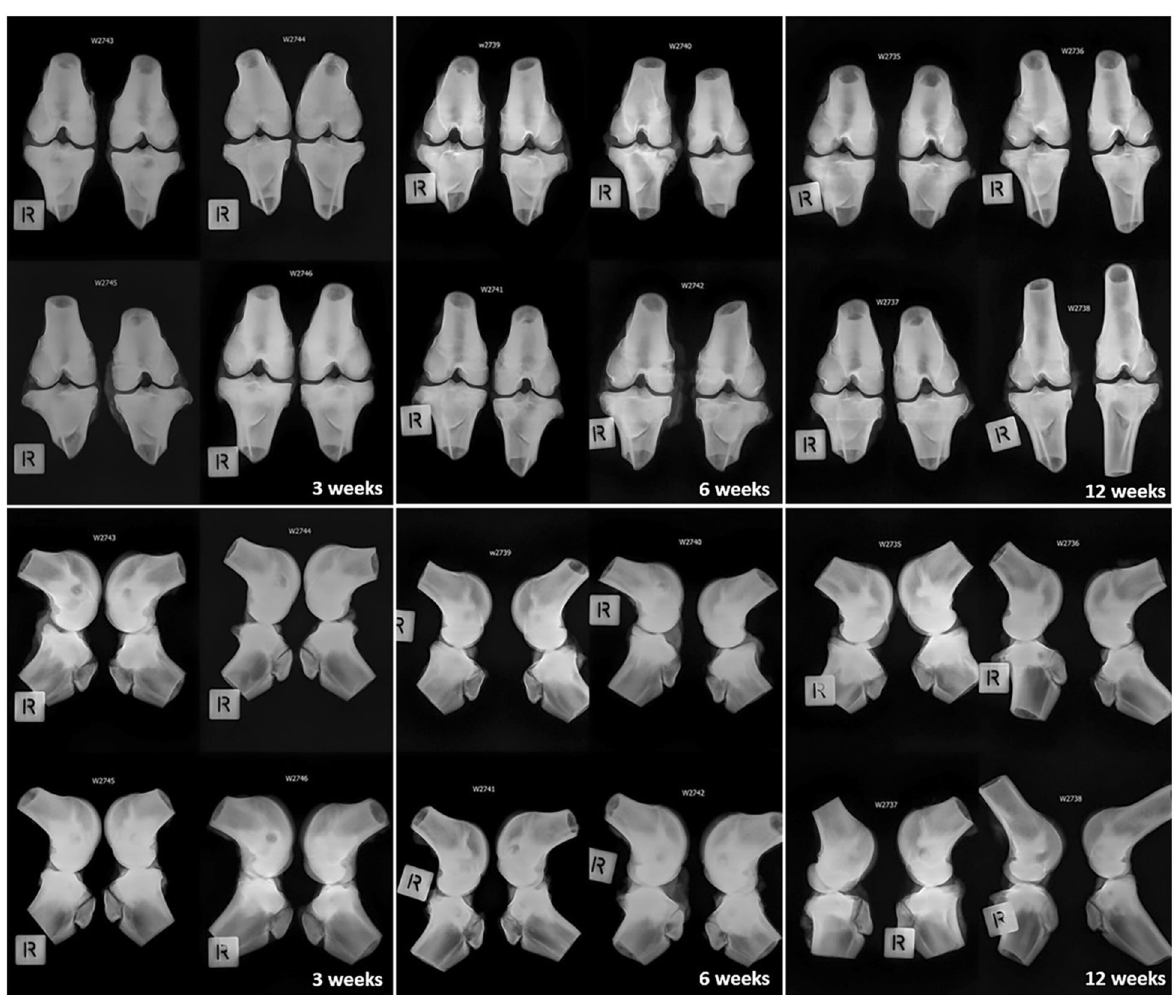
Fig. 3 Anteroposterior (Top) and Lateral (Bottom) X-Rays. Repre- sentative X-Ray images of the right and left hind limbs throughout the duration of the study. Anteroposterior (AP) and Lateral (LAT) images